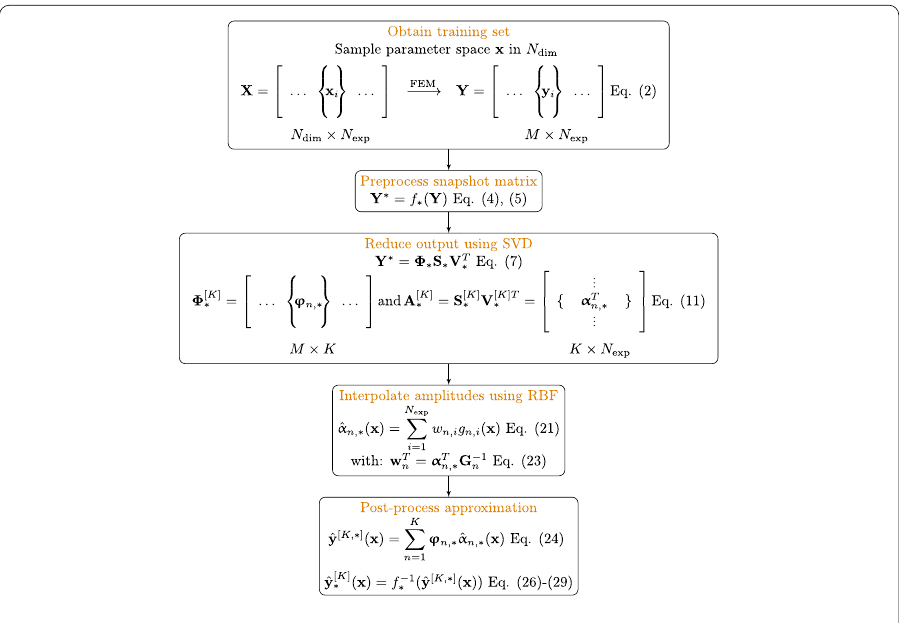
Fig. 1 Construction of a POD-based surrogate